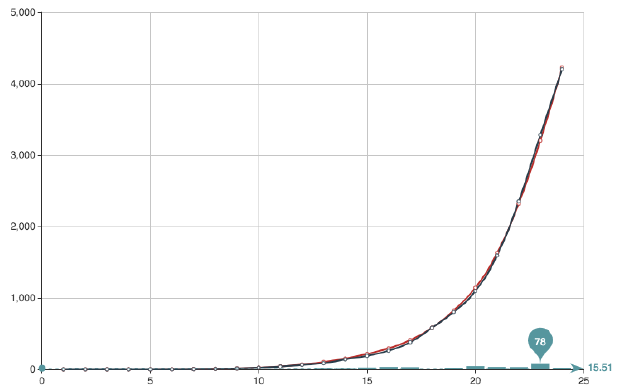
Figure 8. Joint representation of data and fitting using genetic